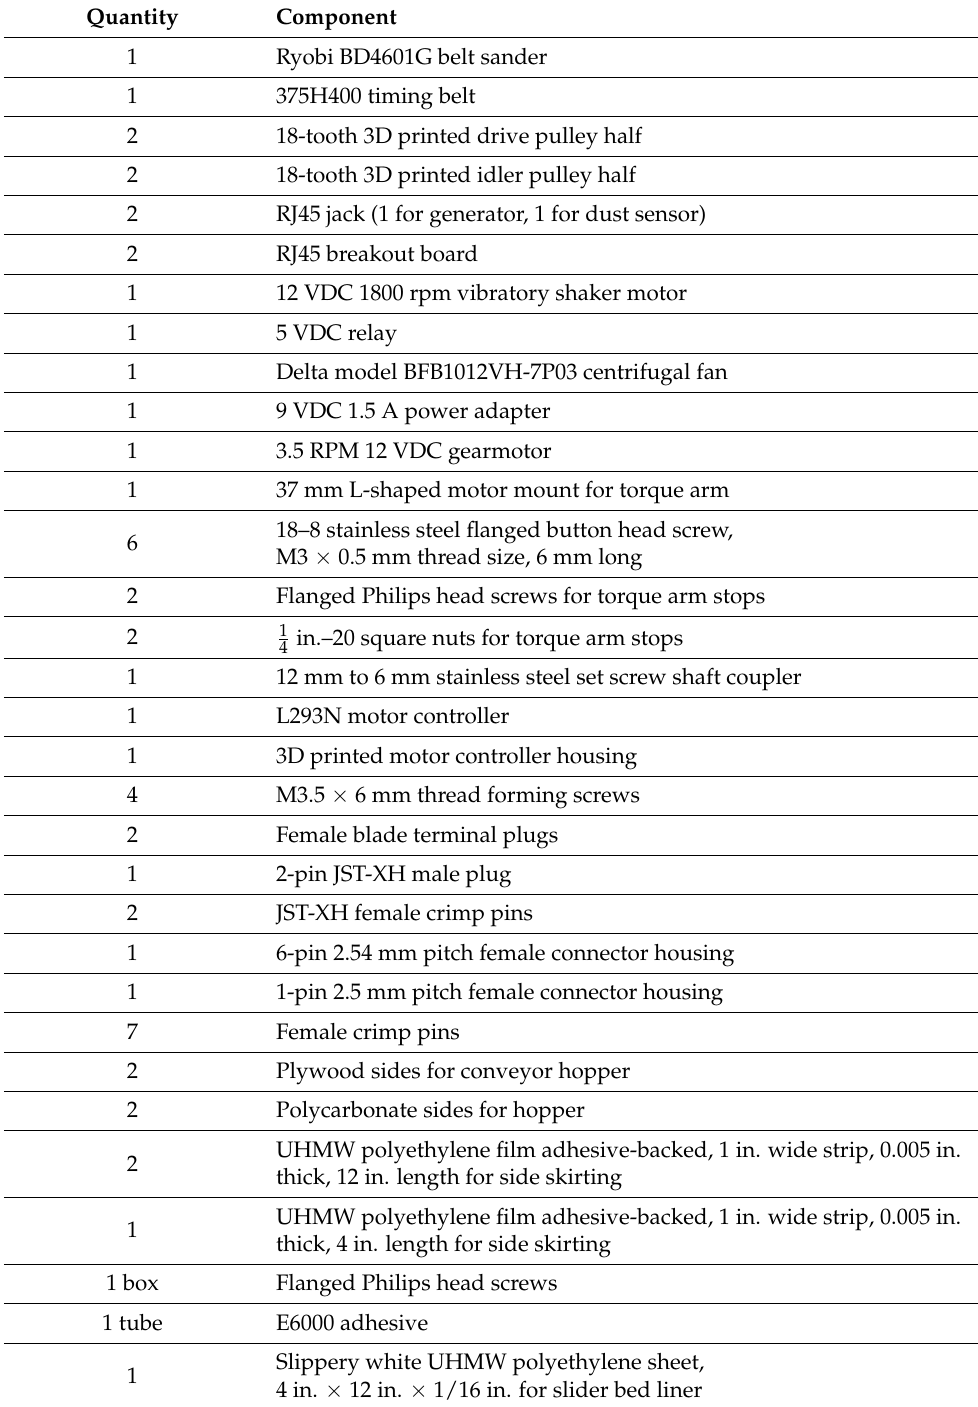
Table A1 is a list of parts and electronic components used to build and control the dust generator. Table A1. Parts list for automatically controlled dust generator and